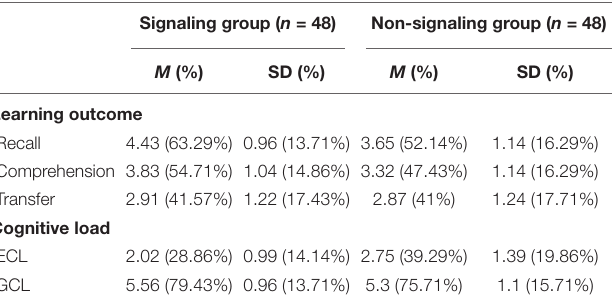
TABLE 2 | Means, standard deviations, and ANOVA/ANCOVA results, separately for the signaling and non-signaling condition. Signaling group ( n =